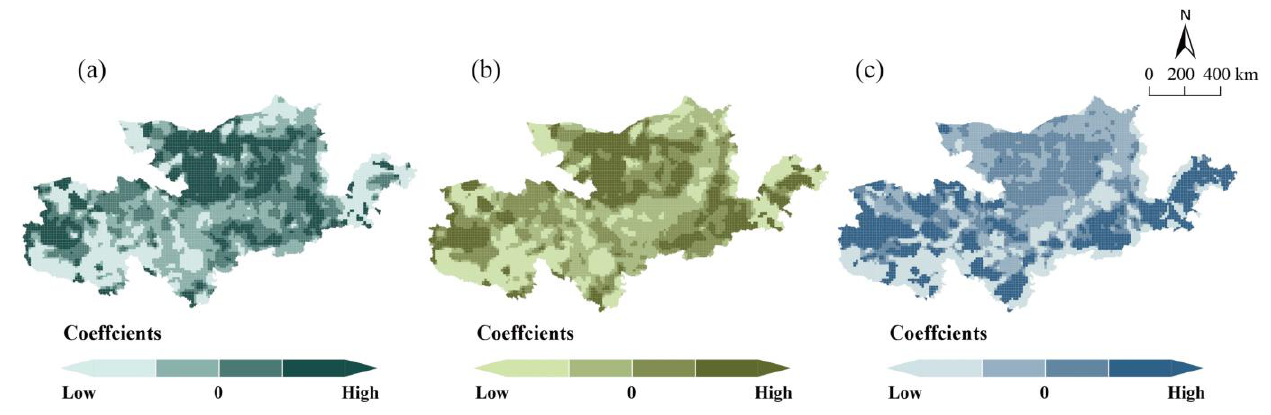
Figure 6. Spatial-response characteristics of different ESs to ERS from 1990 to 2015. ( a ) habitat qual- ity; ( b ) carbon storage; ( c ) soil conservation. Regression coefficients greater than 0 represent a positive correlation between the cumulative area of ERS in different grids and the variation value of ESs. The darker the color, the higher the degree of influence of ERS on ESs.